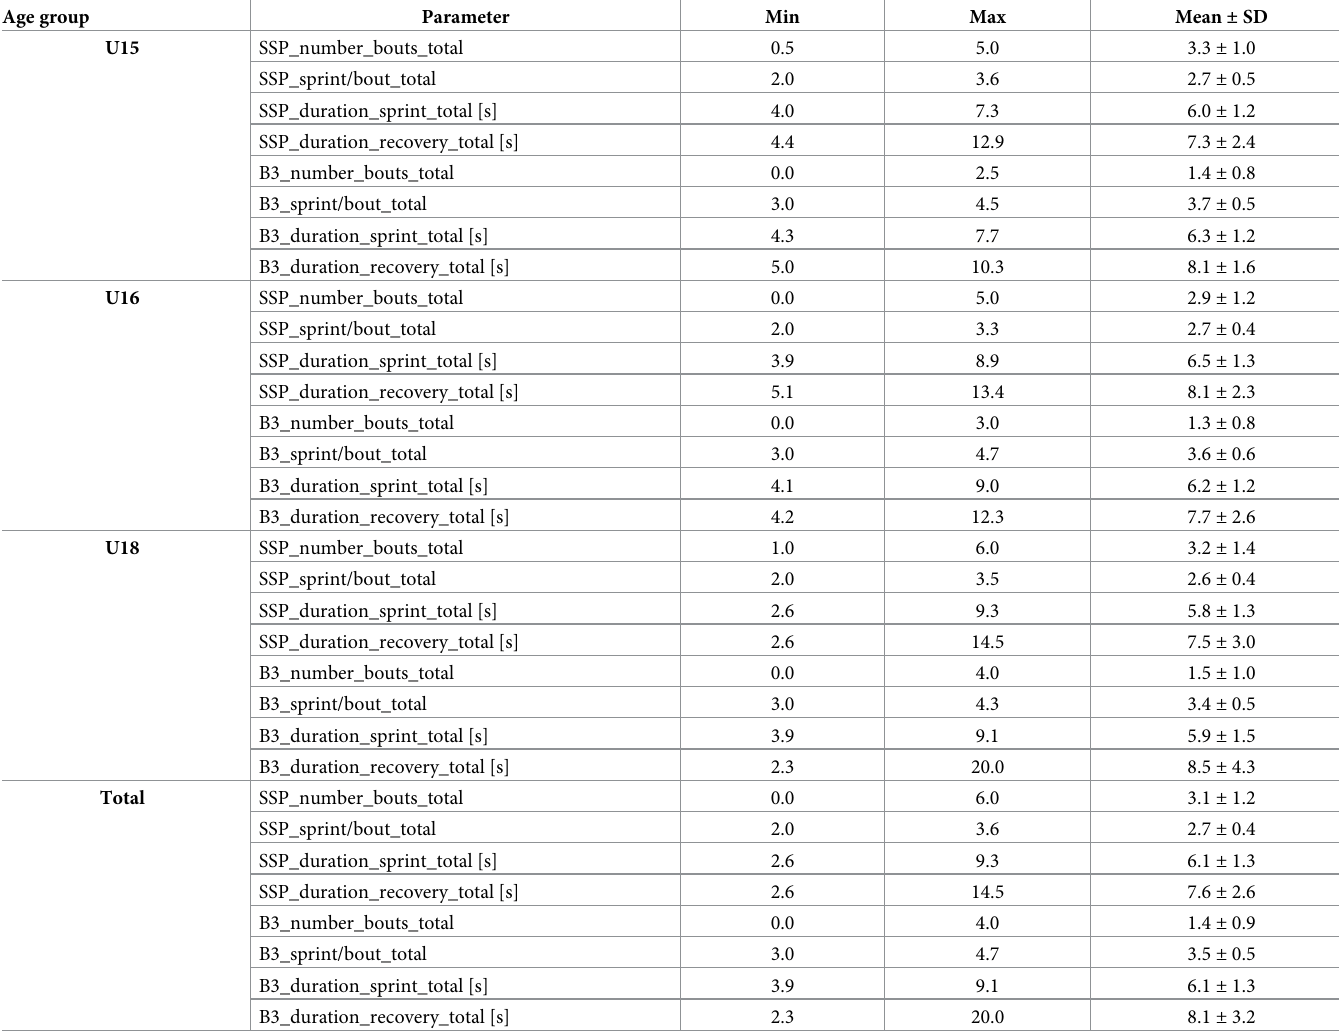
Table 3. Repeated sprint ability parameters for the total training sessions. Age